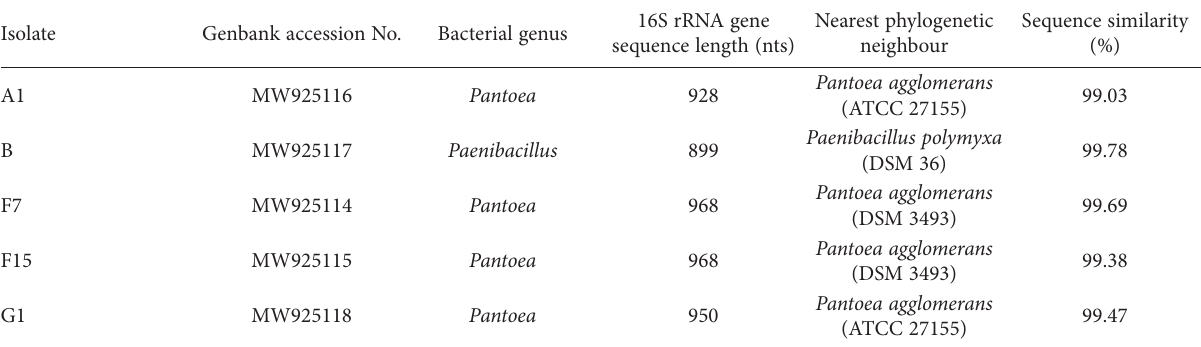
Table 2. BLAST analysis results for different bacterial endophytes isolated from seeds of durum wheat landrace “Timilia reste nere”.